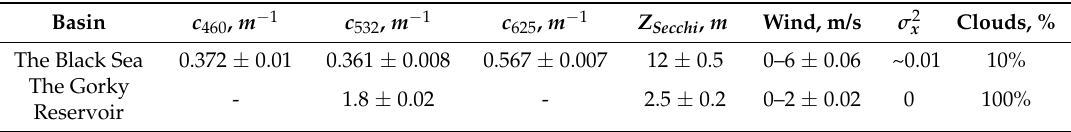
Table 2. General information on the surface waves, optical properties of water and sky conditions on the days of experiment according to data of concurrent